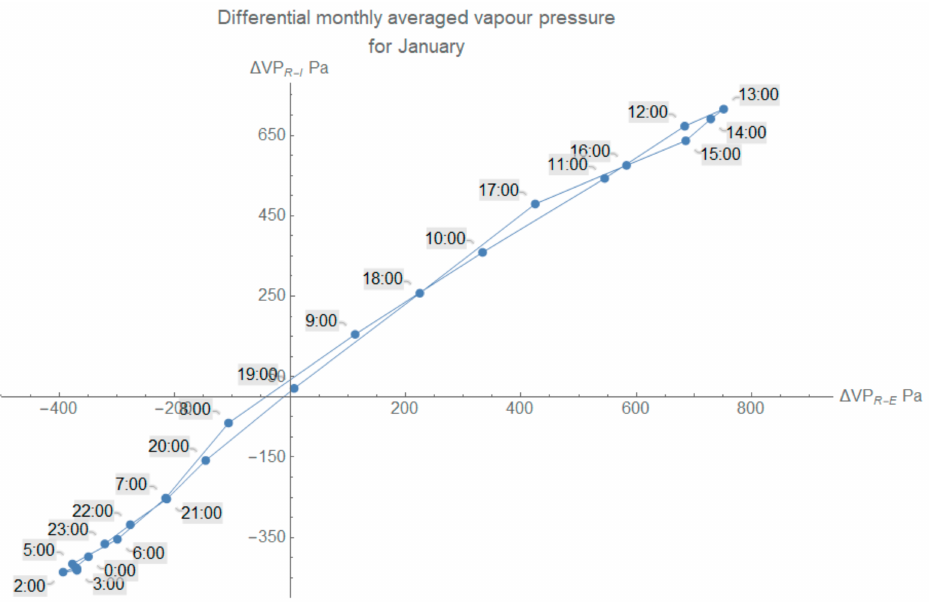
Figure 8. Averaged hourly water vapour pressure difference between the roof cavity and the inside ( ∆ VP R-I ) and the external climate ( ∆ VP R-E ) for the New Plymouth case study. Recordings in quadrant I ( top right ) mean that the roof cavity water vapour pressure is higher than the outside and the inside. Quadrant III ( bottom left ) has the opposite